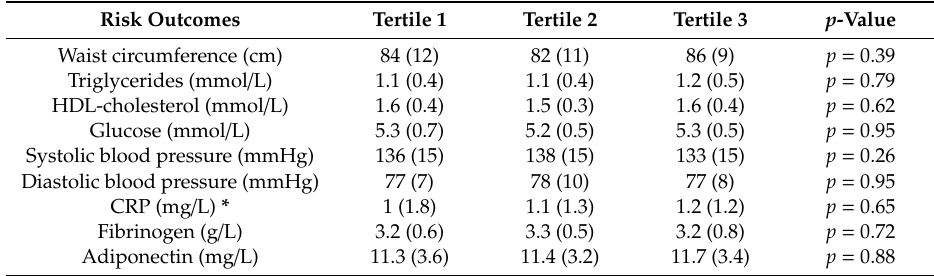
Table 3. Inflammatory and metabolic biomarkers across tertiles of the dietary inflammatory index (DII).